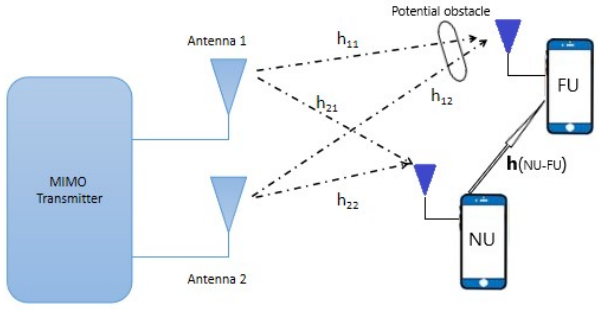
Figure 3. C ooperative SWIPT MIMO-NOMA in THz model. Figure 3. Cooperative SWIPT MIMO-NOMA in THz